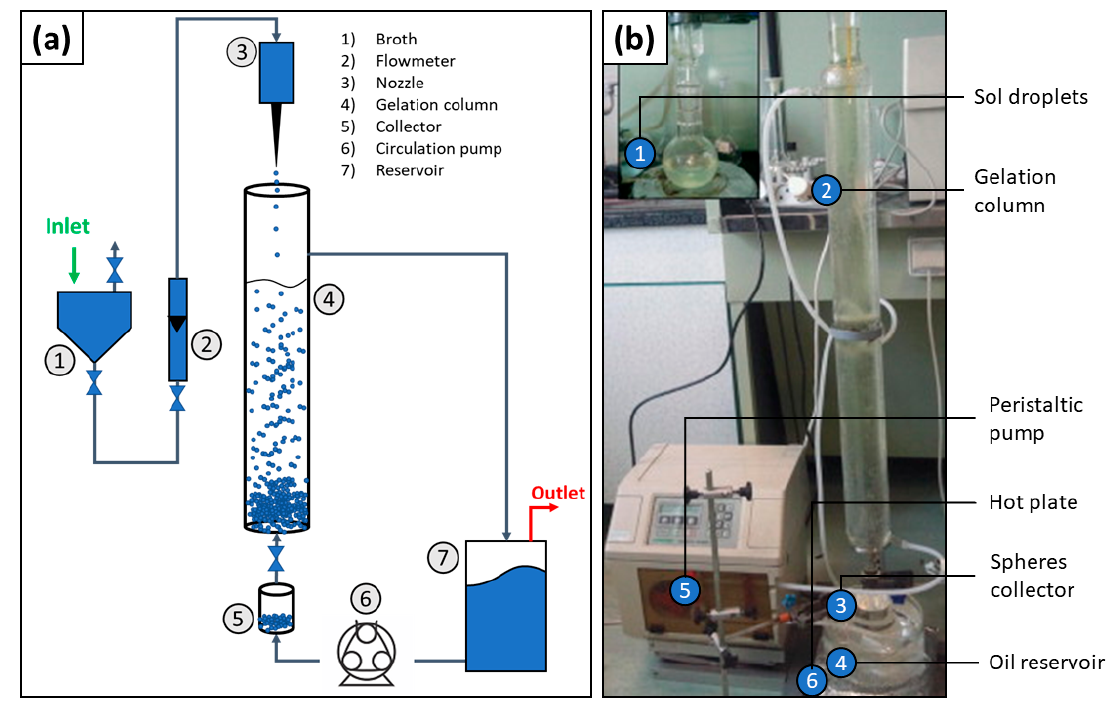
Figure 7. ( a ) Schematic of a generic internal gelation apparatus and ( b ) picture of a typical experimental setup. Figures ( b ) adapted with permission from Poorbaygi et al. [59].